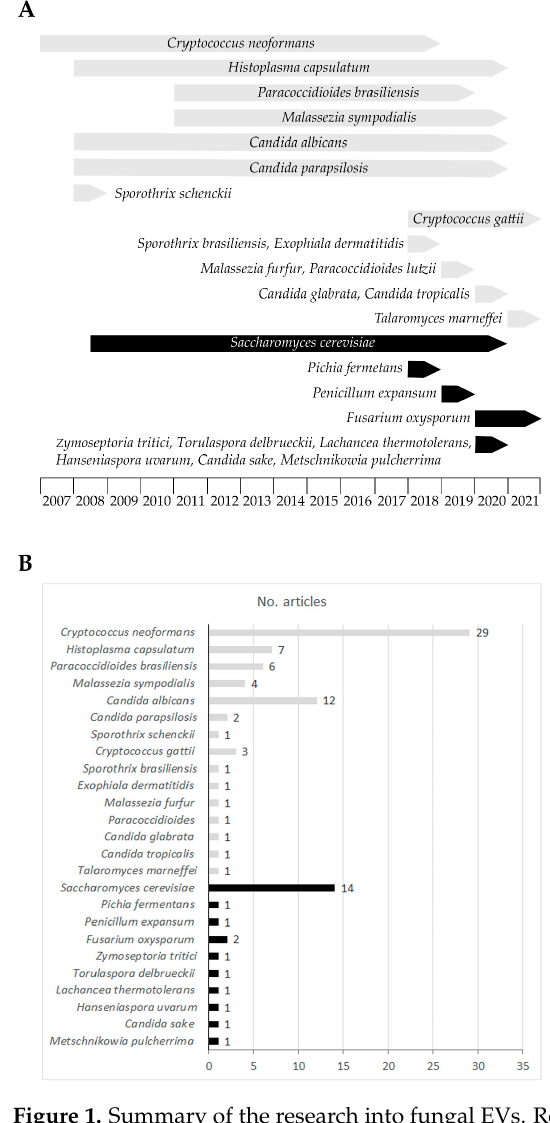
Figure 1. Summary of the research into fungal EVs. Research activity for each species is displayed ( A ) over time or ( B ) according to the number of articles published. In both panels, human pathogen species are represented in grey and those with industrial impact in